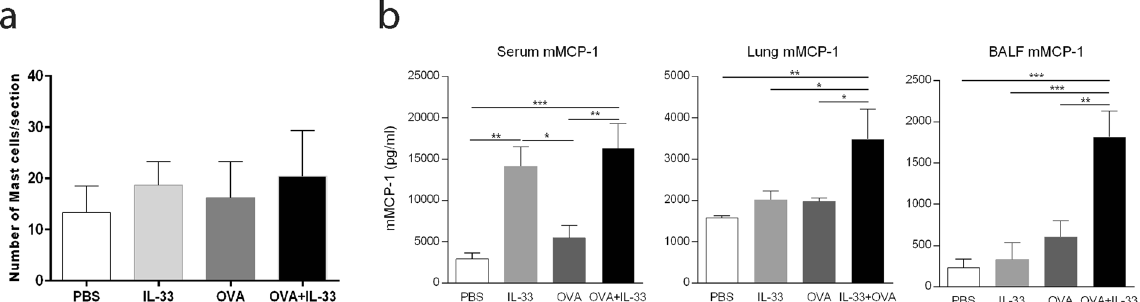
Figure 3. IL-33 treatment of OVA-sensitized mice leads to enhanced mast cell activation but no change in mast cell number. ( a ) Number of mast cells was determined in lung sections, counted in nine sections per mouse. ( b ) Mast cell protease mMCP-1 levels were measured in BALF, lung and serum. * p < 0.05, ** p < 0.01, *** p < 0.001 (ANOVA, Bonferroni). Results are pooled data of four independent experiments (mean ± SEM for ( a ) n = 7–9 and ( b ) n = 4–10 mice in each